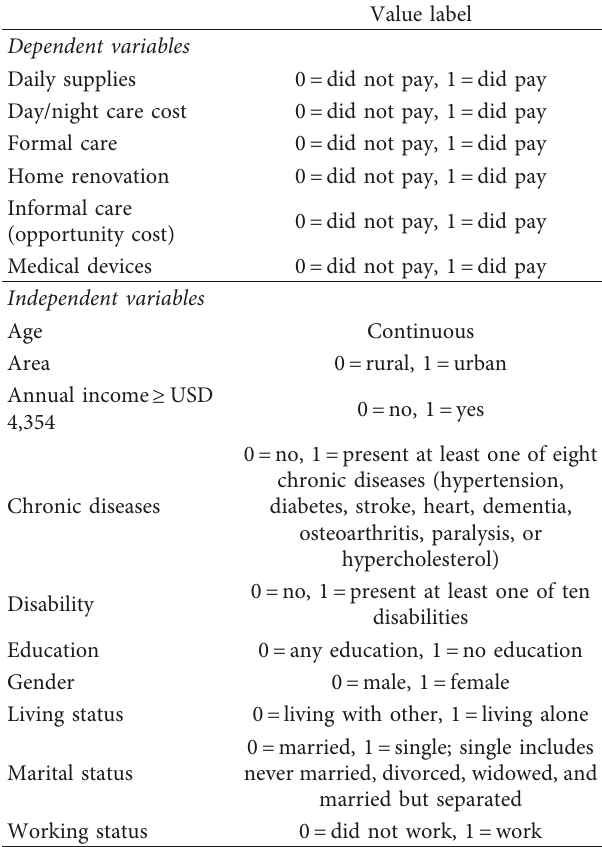
Table 2: Study variables for logistic regression.